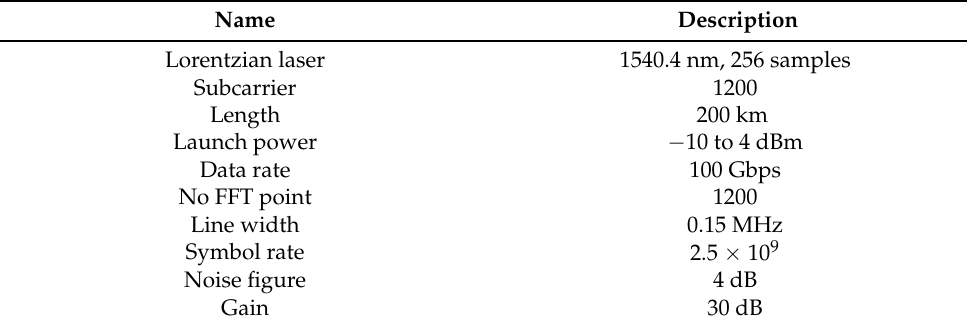
Table 1. Description of parameters utilized for evaluating proposed system